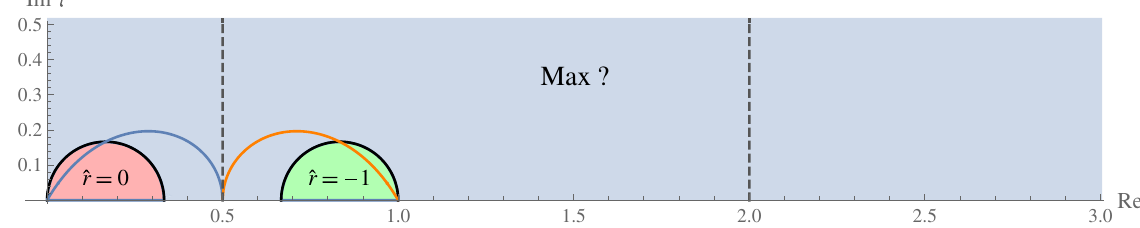
FIG. 3. Stokes lines in the τ plane. The red semicircle corresponds to the domain of analyticity where the r ¼ 0 contribution dominates the index. The green semicircle instead corresponds to the domain where the r ¼ − 1 contribution dominates. In the remaining region we do not have a dominant contribution. The blue and orange lines are the critical points of the entropy function for BPS black holes, in the two possible formulations.